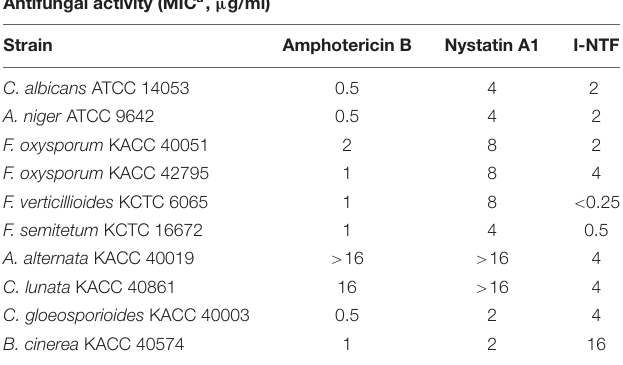
TABLE 3 | In vitro antifungal